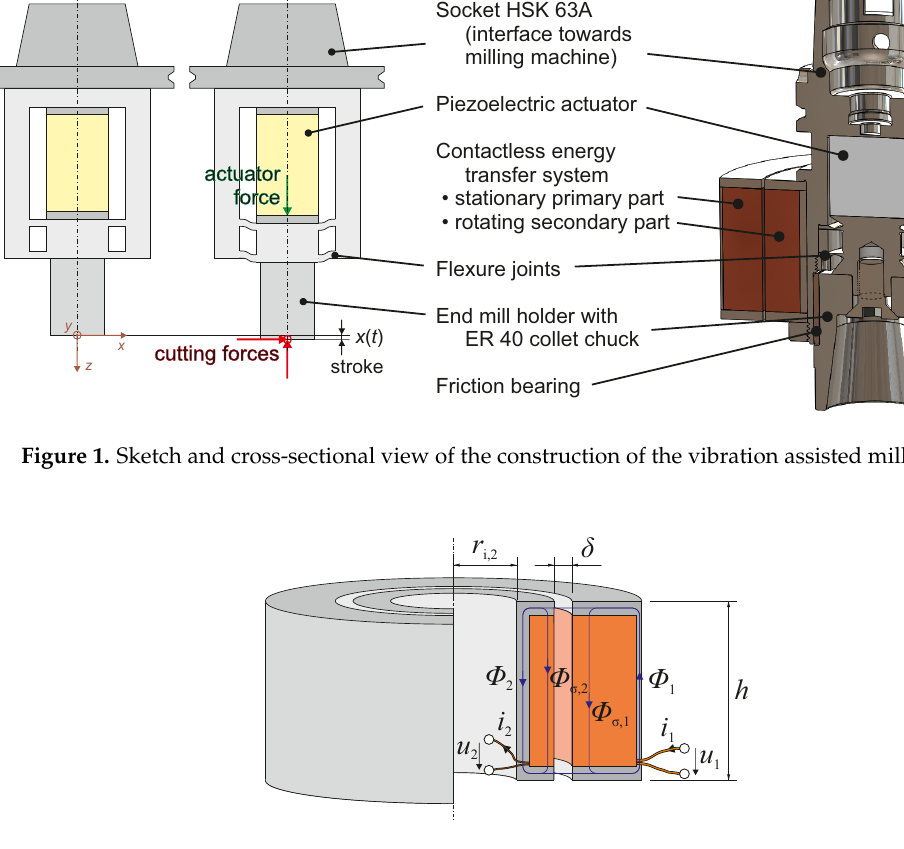
Figure 2. Sketch of the magnetic